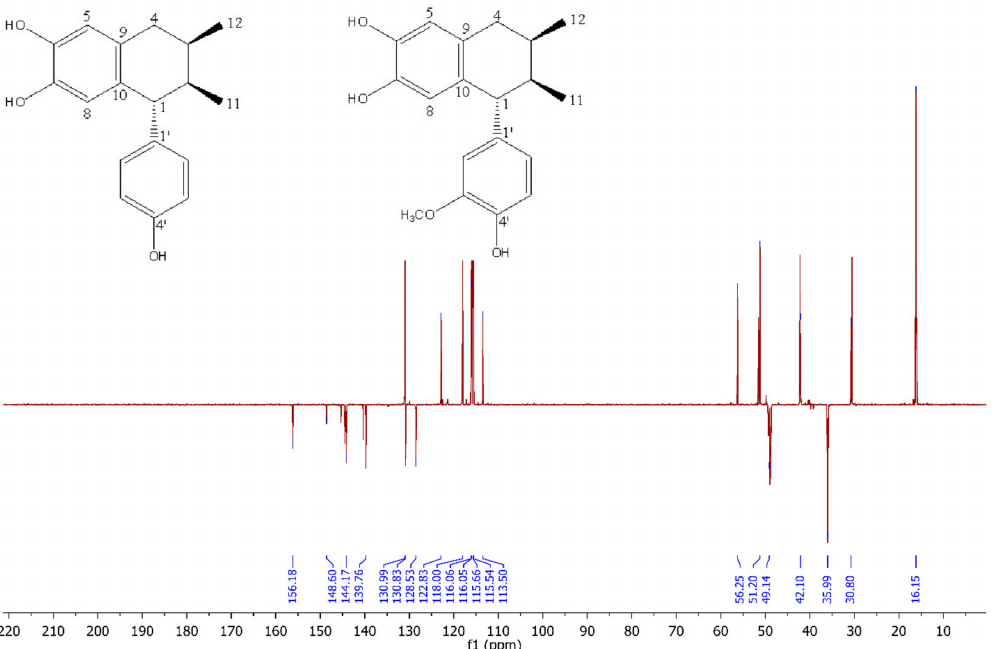
Figure A3. 13C(DEPT) NMR (CD3OD, 150 MHz) of 3 (cid:48) -demethoxy-6-O-demethylisoguaiacin 26 ( 1 ) and norisoguaiacin ( 2 ) 27.